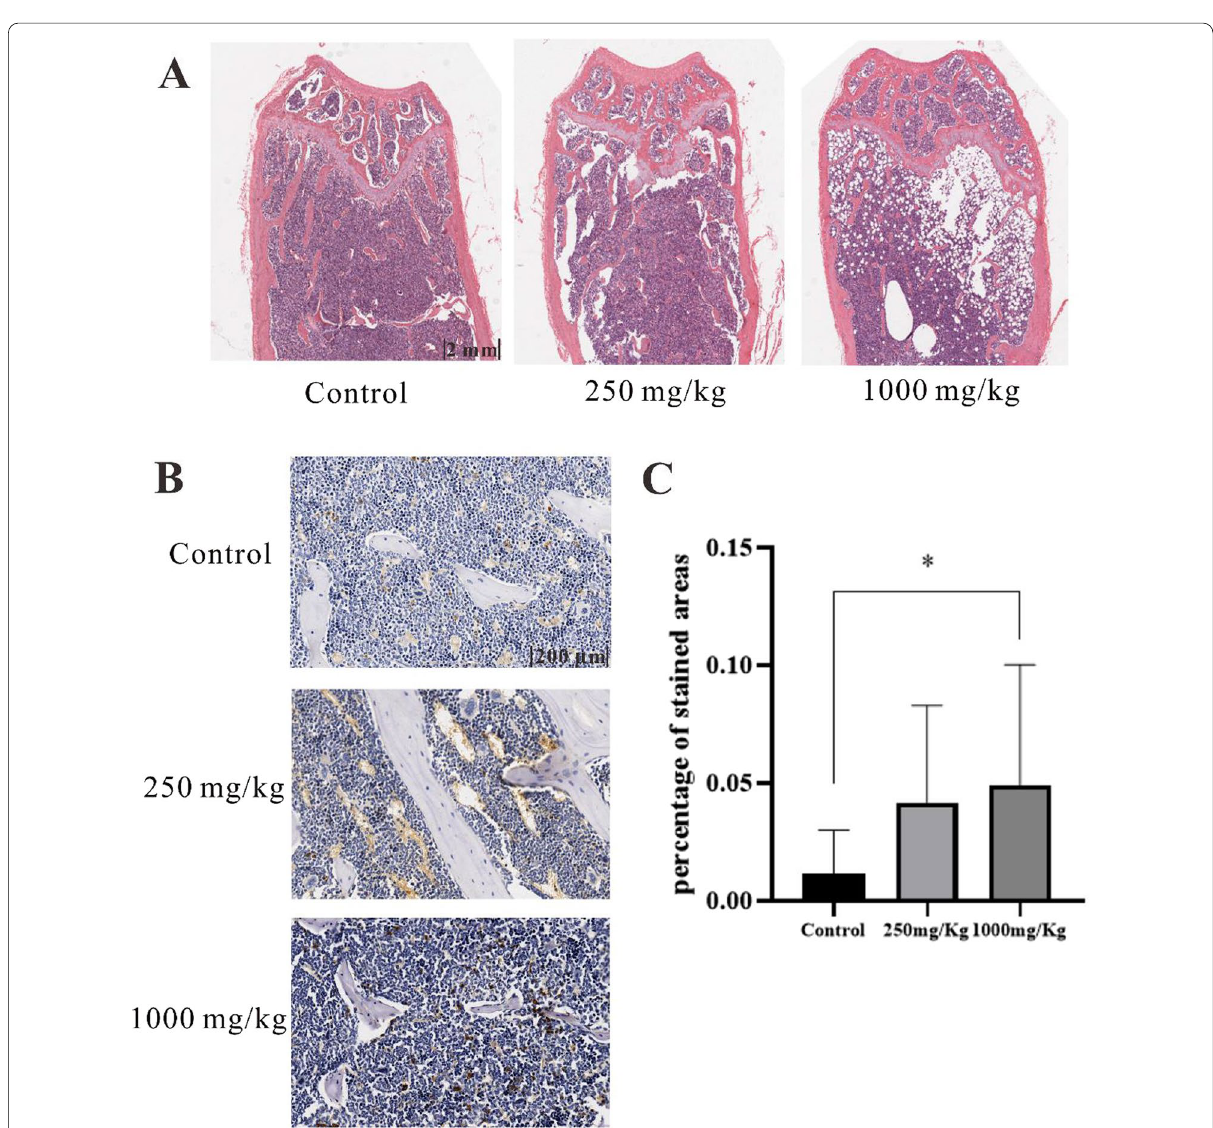
Fig. 13 HE staining of femurs and the expression of CHOP after intragastric administration of LPZ for 6 months (n treated with increasing doses of LPZ showed bone damage, as determined by HE staining. B Mouse femur immunohistochemical analysis of CHOP (n 3, Scale 200 µm). C Semiquantitative calculation of CHOP was performed with = =